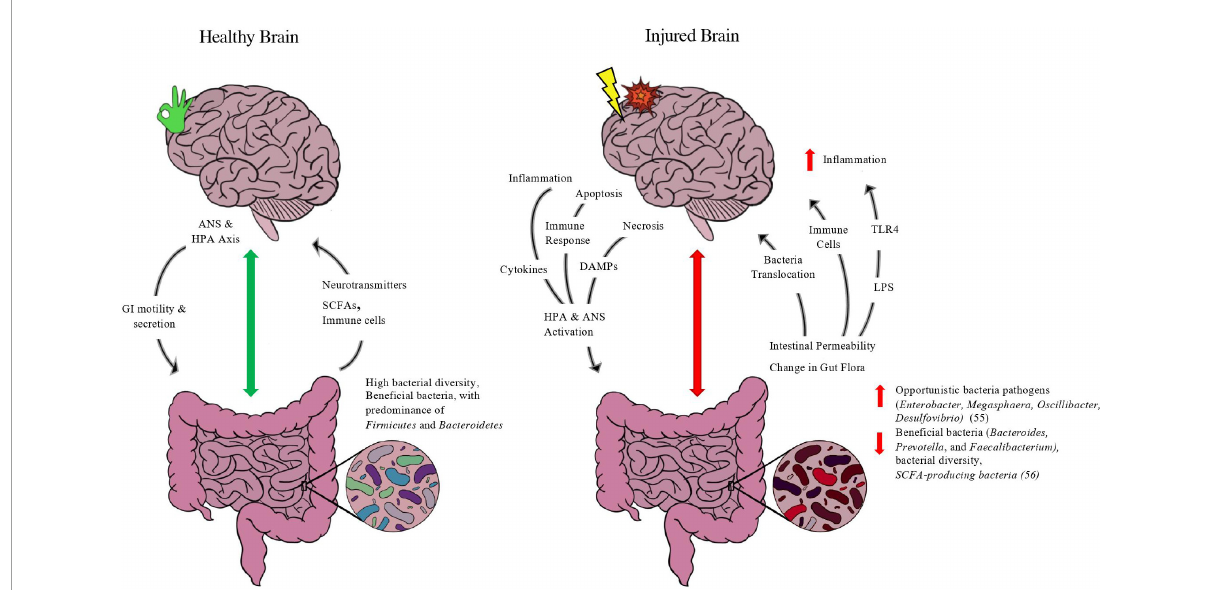
FIGURE1 Purported model of gut-brain axis in healthy and injured brain. Depicted in figure is the bidirectional exchange between the brain and the gut in both a healthy state and injured state. In normal functioning, the brain’s neuroendocrine control of the gut through the autonomic nervous system (ANS) and hypothalamus-pituitary-adrenal (HPA) axis via the Vagus Nerve releases molecules such as acetylcholine and corticotropin-releasing hormone (CRH) to modulate enteric functions such as contractility, secretion of digestive enzymes, and immune function. A balanced microbiome with favorable features such as high bacterial diversity and abundance of beneficial taxa of bacteria such as firmicutes and short-chain-fatty-acid (SCFA) producing bacteria, such as Roseburia and Faecalibacterium , will exchange metabolites up